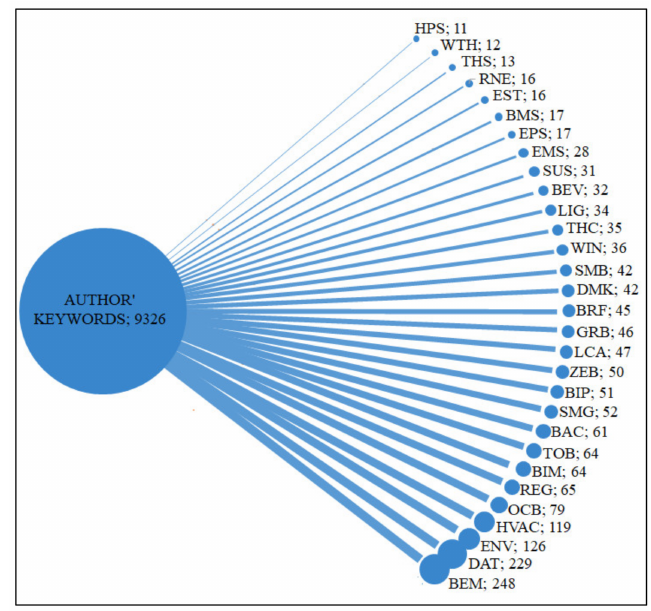
Figure 5. Keywords category (theme) and their number of members (source: authors).